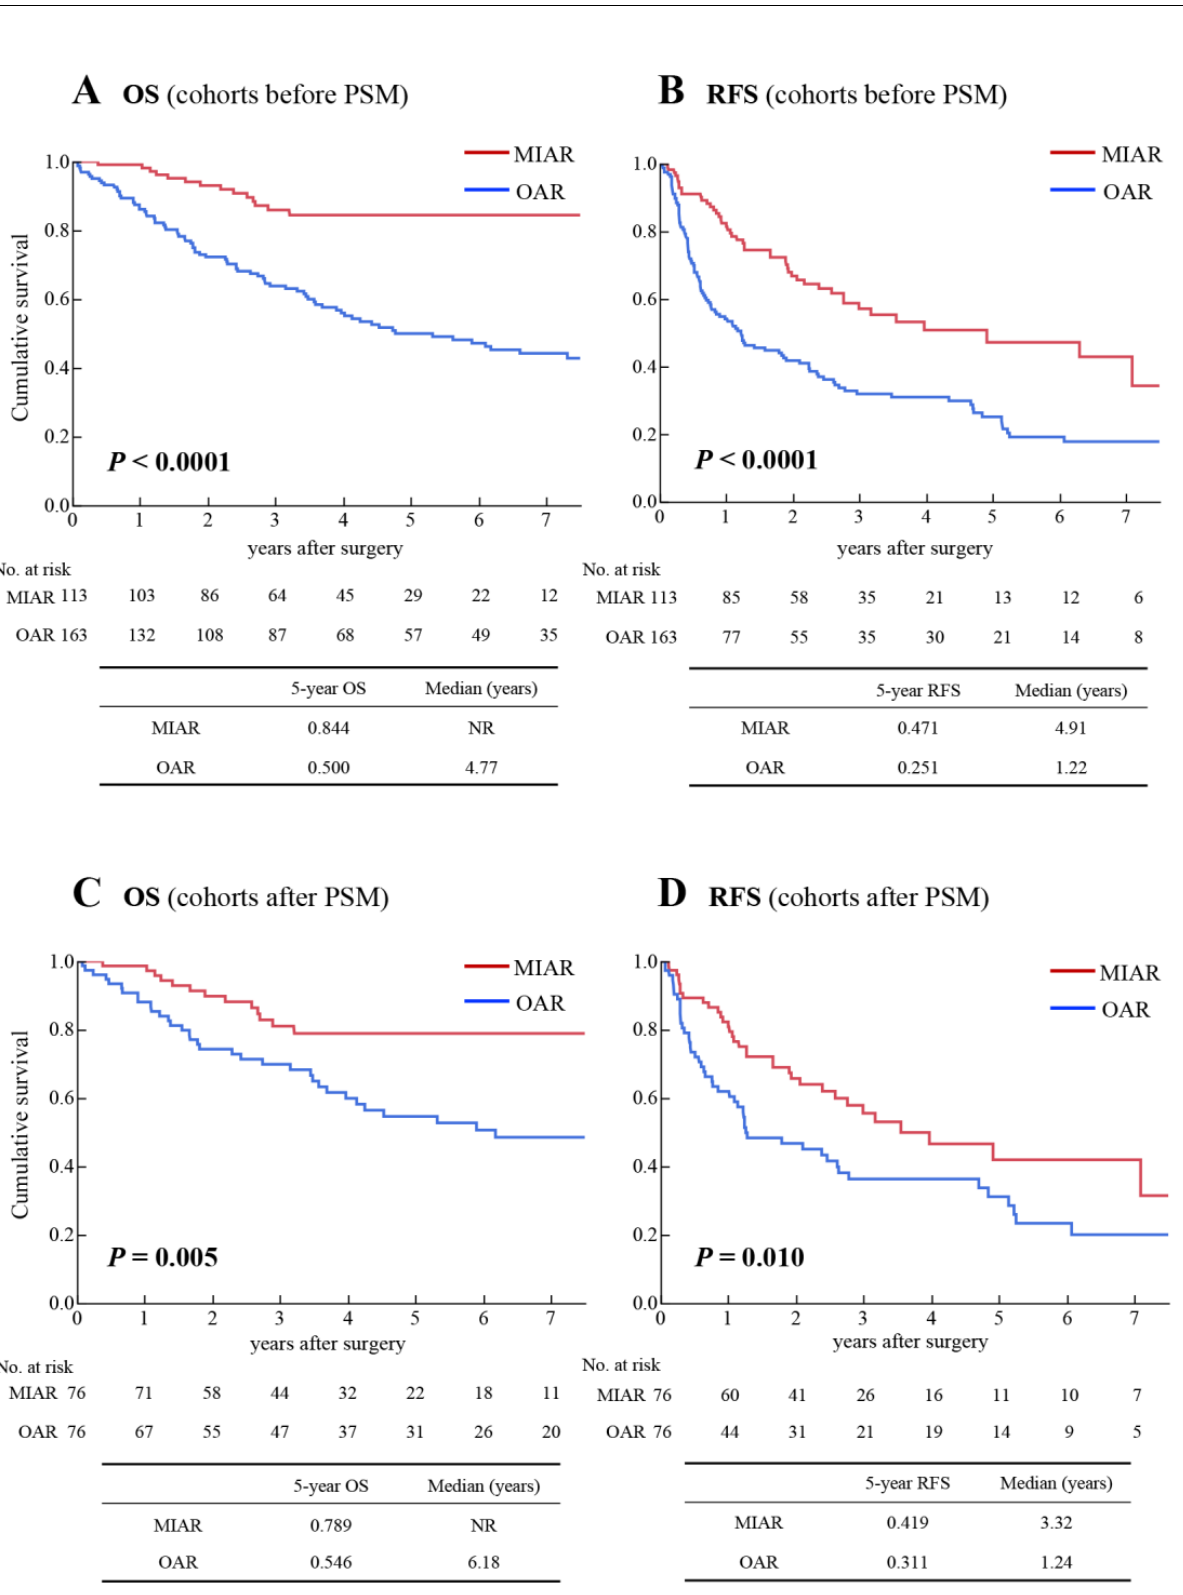
Figure 2. Overall (OS) and recurrence-free (RFS) survivals after OAR and MIAR: ( A ) OS in the comparative cohorts before PSM; ( B ). RFS in the comparative cohorts before PSM; ( C ) OS in the comparative cohorts after PSM; ( D ) RFS in the comparative cohorts after PSM; NR: not reached.